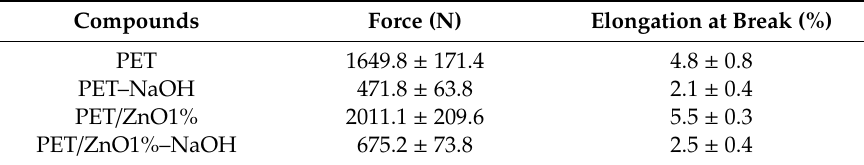
Figure 7. Stress versus strain plot of tested compounds. Table 4. Tensile properties of PET and PET/ZnO under effect of NaOH.